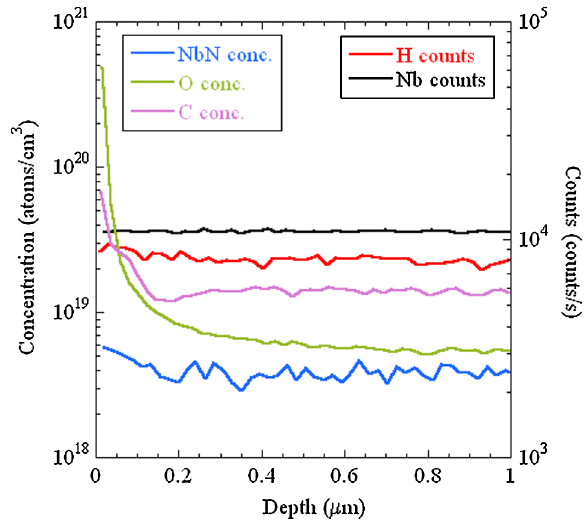
FIG. 21. (Color) SIMS reduced data depth profile for the heat treated sample L10. The heat-treatment parameters are